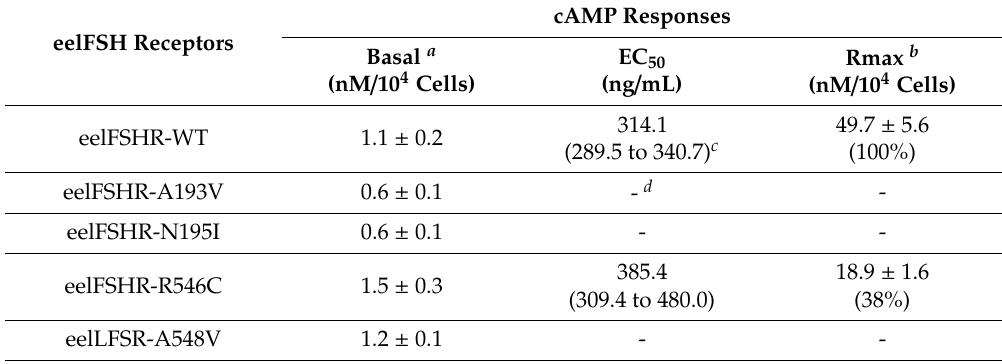
The data are from three individual experiments. The half maximal e ff ective concentration (EC 50 ) values were determined from the concentration–response curves from in vitro bioassays. a Basal cAMP level average